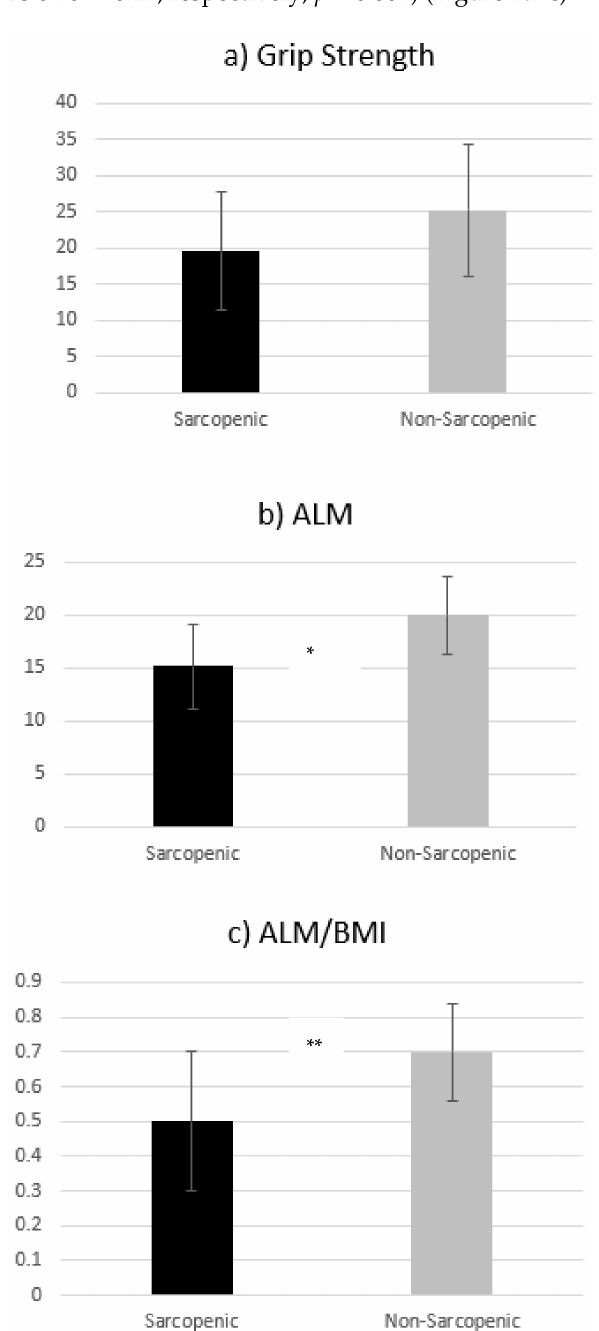
Figure 1. Differences between sarcopenic and non-sarcopenic patients, as categorized according to Foundation for the National Institutes of Health (FNIH) criteria. ( a ) Grip strength of sarcopenic and non-sarcopenic patients; ( b ) ALM of sarcopenic and non-sarcopenic patients; ( c ) ALM/BMI of sarcopenic and non-sarcopenic patients. ALM: appendicular lean mass; ALM/BMI: appendicular lean mass adjusted for body mass index; * p < 0.05; ** p <